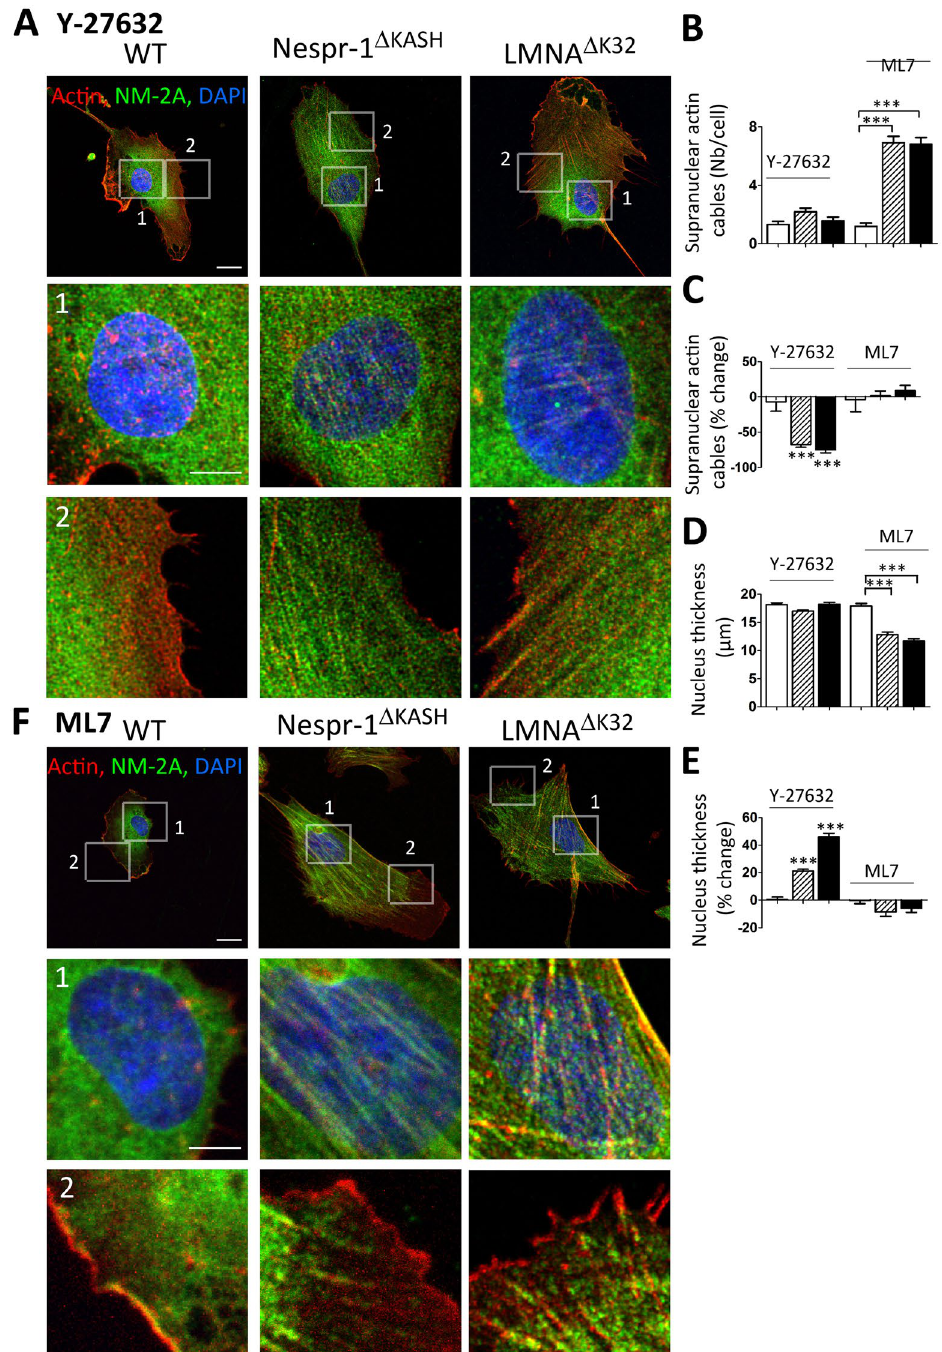
Figure 4. Effects of ROCK and MLCK inhibition on actin cytoskeleton in myoblasts on soft matrix (12 kPa). ( A , F ) Confocal images of WT, Nespr-1 Δ KASH and LMNA Δ K32 myoblasts on soft matrix and stained for F-actin (phalloidin, red) and NM-2A (green) after treatment with the ROCK inhibitor Y-27632 ( A ), and the MLCK inhibitor ML7 ( F ). Nuclei are stained with DAPI (blue). Scale bar: 10 µ m. Images 1 and 2 show higher magnification of the perinuclear and periphery zones respectively. Zoom-in scale bar: 5 µ m. ( B , C ) Supranuclear actin cable number in WT, Nespr-1 Δ KASH and LMNA Δ K32 myoblasts after treatment with Y-27632 or ML7. Values are expressed as absolute numbers ( B ) and as percent of baseline values for each cell line ( C ). ( D , E ) Nucleus thickness in WT, Nespr-1 Δ KASH and LMNA Δ K32 myoblasts after treatment with Y-27632 or ML7. Values are expressed as absolute numbers ( B ) and as percent of baseline values for each cell line ( C ). In ( B – E ), values are means ± SEM; *** p < 0.001 compared with WT ( B , D ) or compared to values before treatment ( C , E ). Only significant difference is